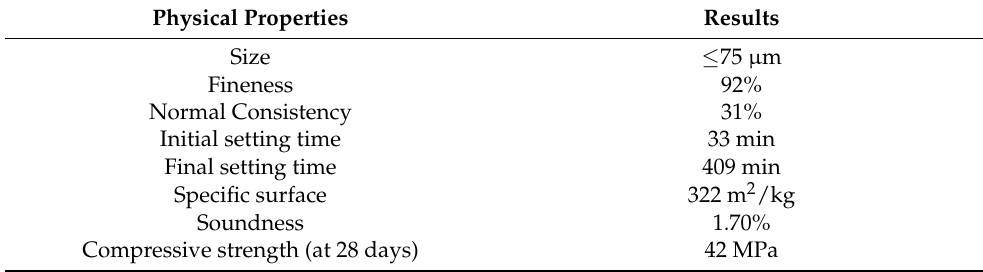
Table 2. Physical Properties of Portland Cement.